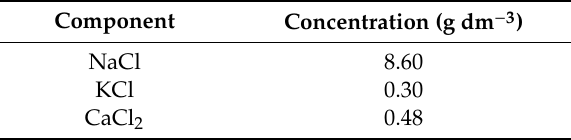
Table 1. Chemical composition of Ringer’s